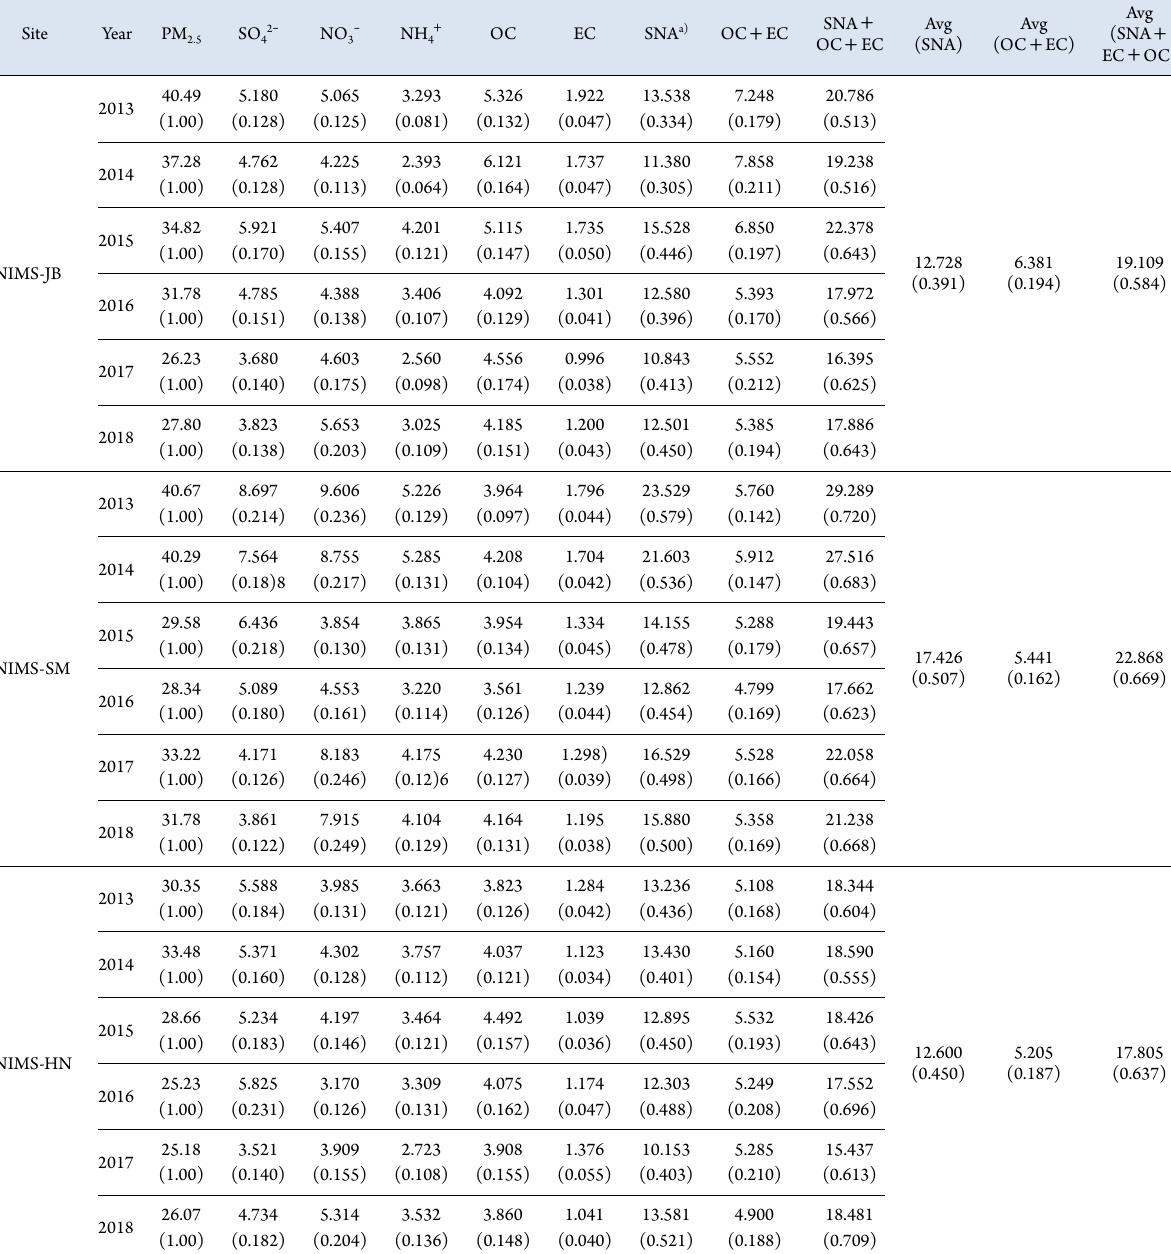
Table S1. Overall summary of annual average concentrations (μg/m 3 ) and mass ratios for 5 major chemical species (Study-2).